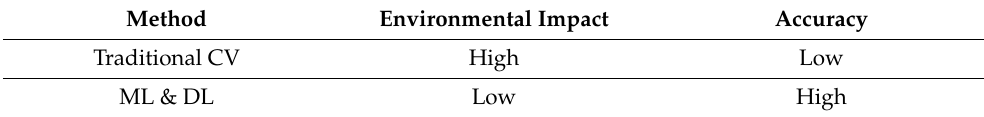
Table 1. Comparison of various methods of skincare products’ recommendation